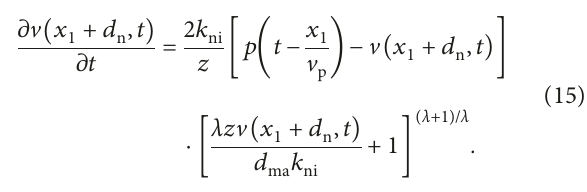
Figure 3: Scheme of left- and right-running characteristics in the x - t